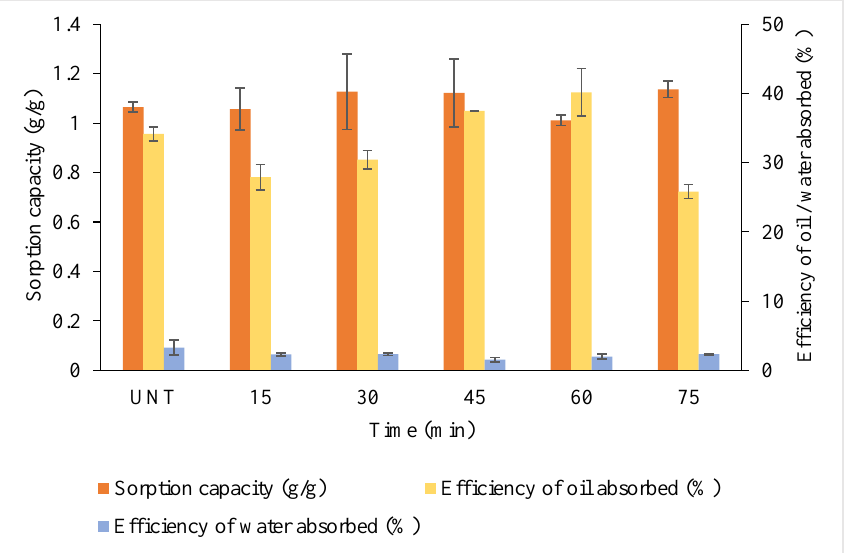
Figure 7. Effects of varying time (min) on sorption capacity and oil/water absorption efficiency. Error bars indicates SD for the three replicates.